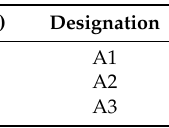
Table 1. Designation of the polymer electrolytes with different amount of glycerol. Glycerol (wt.%) Designation